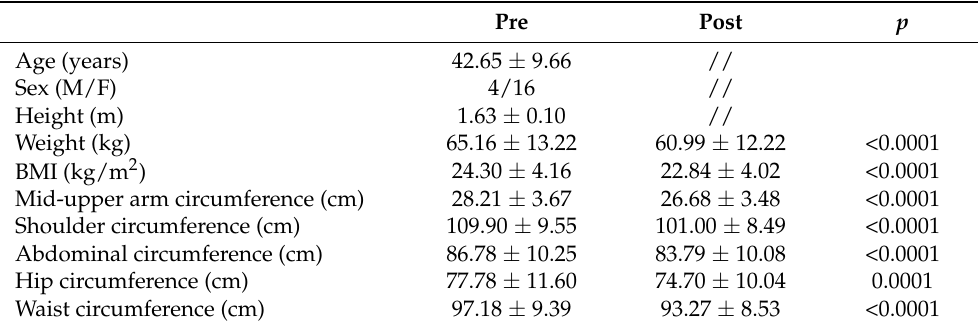
Table 1. Significant reductions in weight, BMI, and abdominal and body circumferences were observed. Table 1. Anthropometric data of the IBS-D patients before and after low FODMAPs diet.